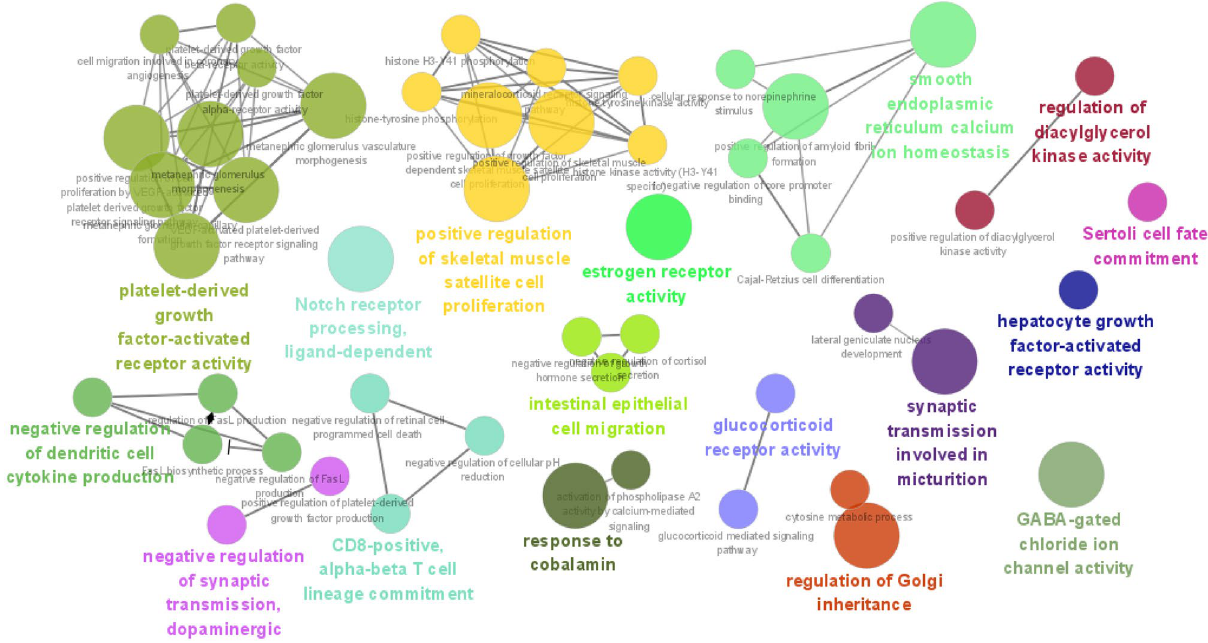
Figure 6. Pathways of brain active chemical compositions based on bioinformation analysis.